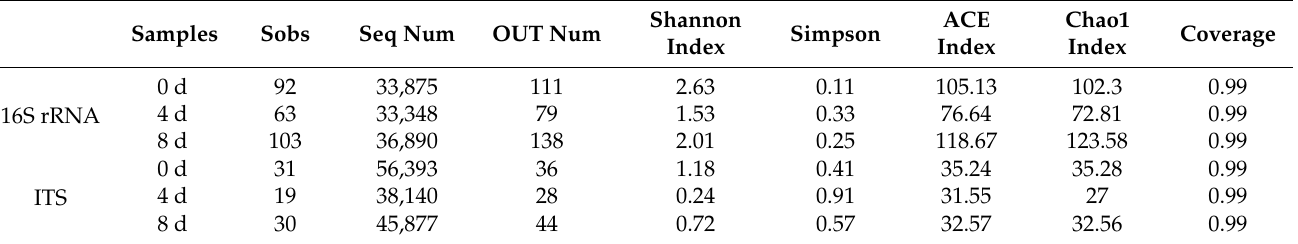
Table 3. The 16S rRNA and ITS diversity index of the vinasse hairtail samples at different stages of